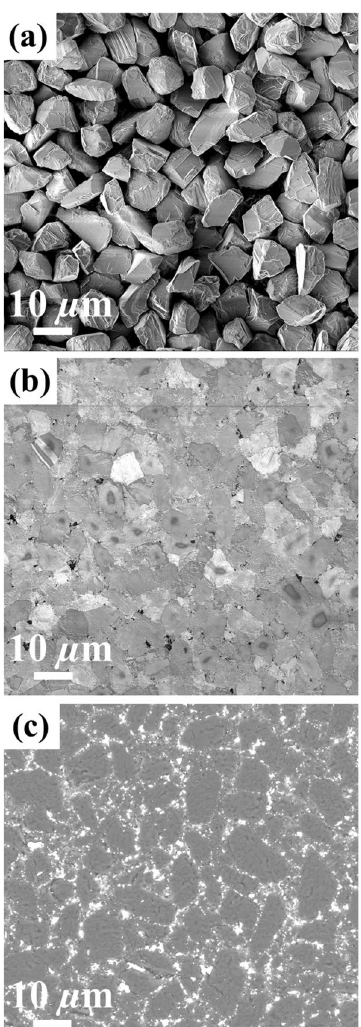
Figure 2. Microstructures of starting diamond powder, polished CFPDC, and polished commercial PDC samples. ( a ) SEM image of starting diamond powder; ( b ) SEM image of the CFPDC sample; ( c ) BSE analysis of the commercial PDC sample. The dark gray region is diamond and the bright region is residual cobalt catalyst. These images show that the diamond grain size is all about 10 µm for both the starting diamond powder and the CFPDC samples, and the commercial PDC sample with the same grain size are also selected for